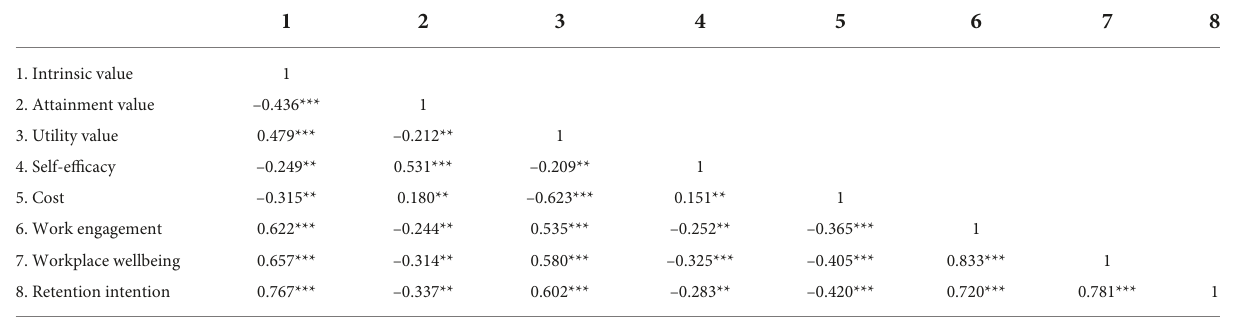
TABLE 1 Correlations of latent variables.